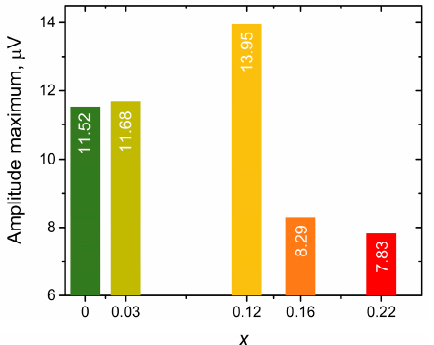
Figure 6. Dependence of the peak amplitude of the THz signal detected with GaSe:S, crystal samples on x .